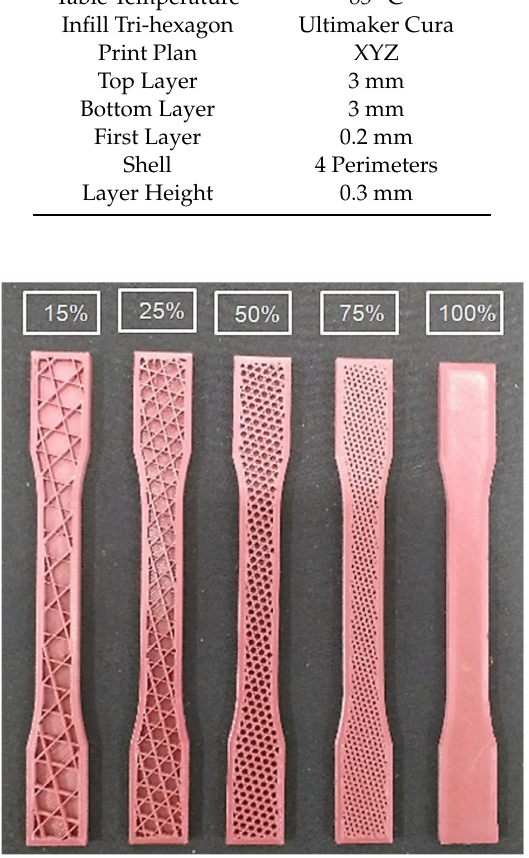
Figure 3. Photo of Proof Bodies (PB) internal geometry distribution of 15%, 25%, 50%, 75%, and 100%